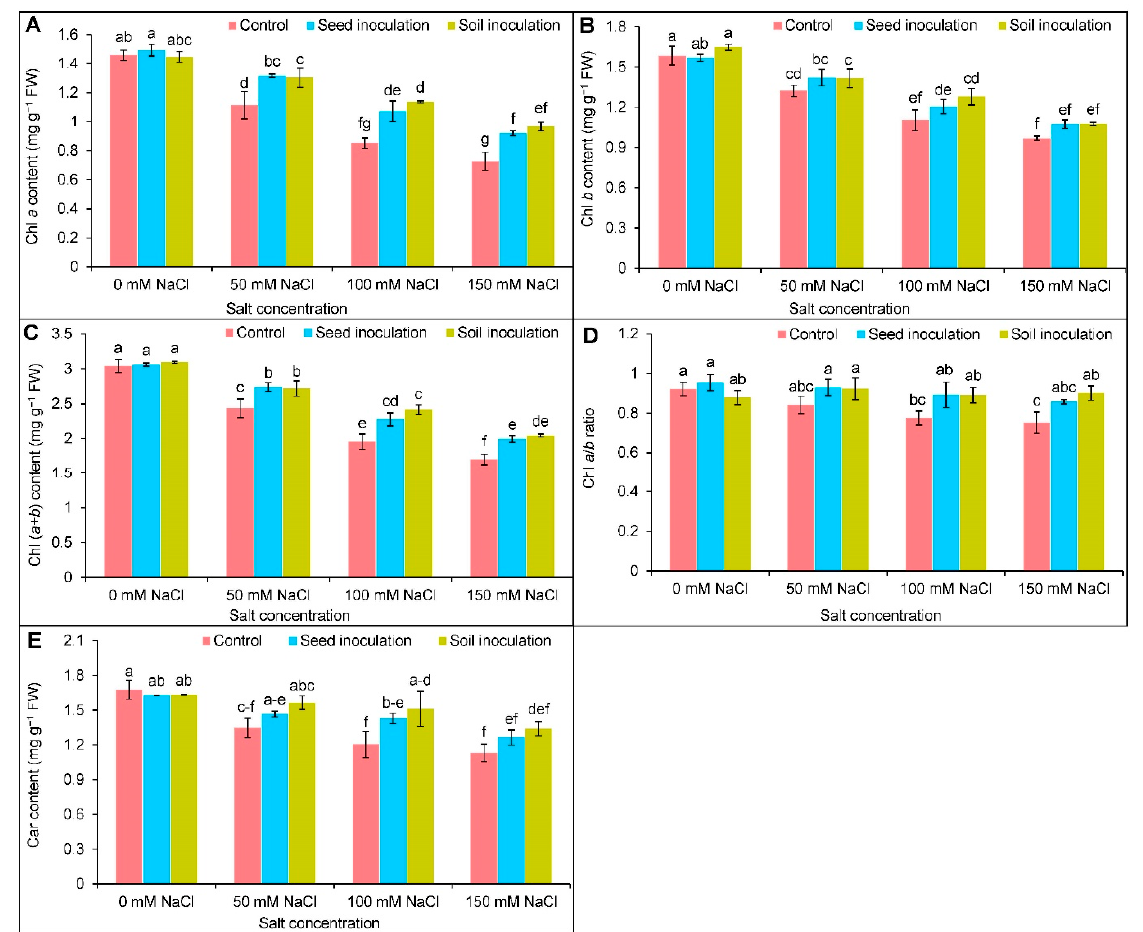
Figure 1. Effect of Bacillus subtilis in response to different concentrations of salt stress on the contents of Chl a ( A ), Chl b ( B ), Chl ( a+b ) ( C ), Chl a/b ( D ), and Car ( E ) of soybean ( Glycine max cv. BARI Soybean-5). Values in a column are mean ± SD. Different letters on each bar indicate significant differences among the treatment after applying a Tukey’s HSD test at p ≤ 0.05.